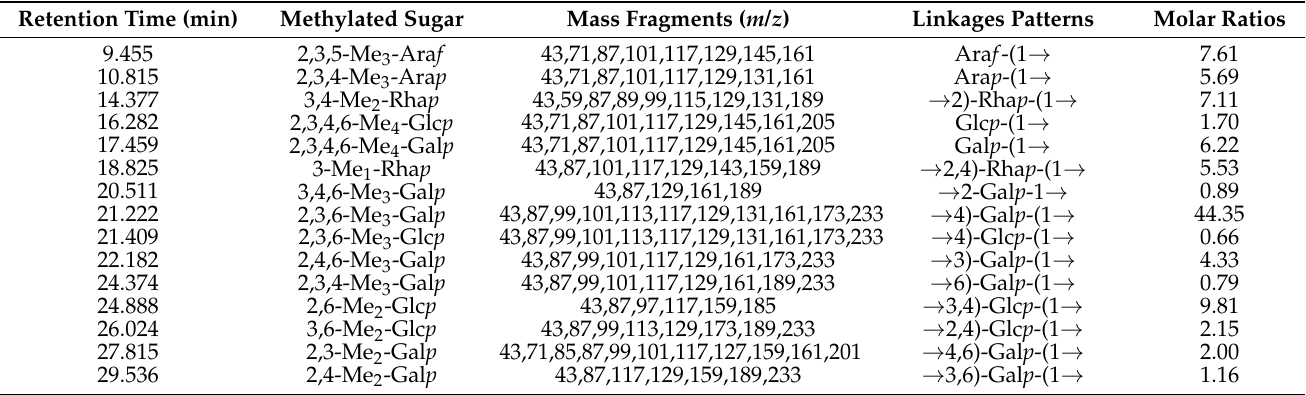
Figure 5. The GC-MS chromatogram of PMAAs of RPP-2a. Table 1. GC-MS analysis of methylated